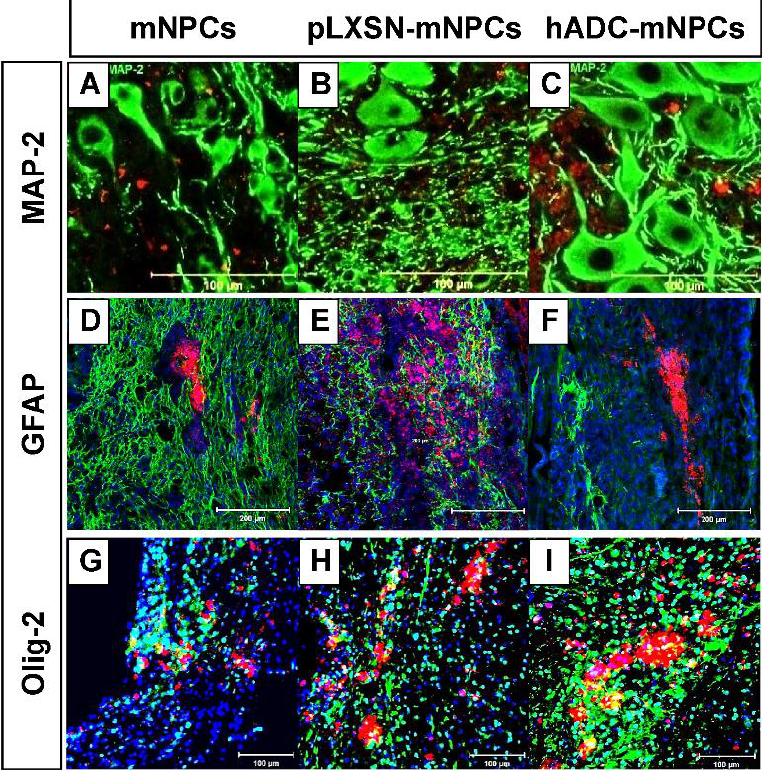
Figure 4. Double immunohistochemistry of PKH-26-labeled mNPCs, pLXSN-mNPCs, and hADC- mNPCs, along with the marker microtubule associated protein-2 (MAP-2), fibrillary acidic protein (GFAP), and Olig-2 around lesion sites after SCI. ( A – C ) Immunofluorescence staining of MaP-2 (green) in PKH-26-labeled mNPCs, pLXSN-mNPCs and hADC-mNPCs (red) at 5 weeks post-transplantation. ( D – F ) Immunofluorescence staining of GFAP (green) in PKH-26-labeled mNPCs, pLXSN-mNPCs and hADC-mNPCs (red) at 1 week post-transplantation. DAPI staining (blue) indicating the nuclei. ( G – I ) Immunofluorescence staining of Olig-2 (green) in PKH-26-labeled mNPCs, pLXSN-mNPCs, and hADC-mNPCs (red) at 1 week post-transplantation. DAPI staining (blue) indicating the nuclei. Scale bar = 100 μm (MAP-2 and Olig-2), 200 μm (GFAP).